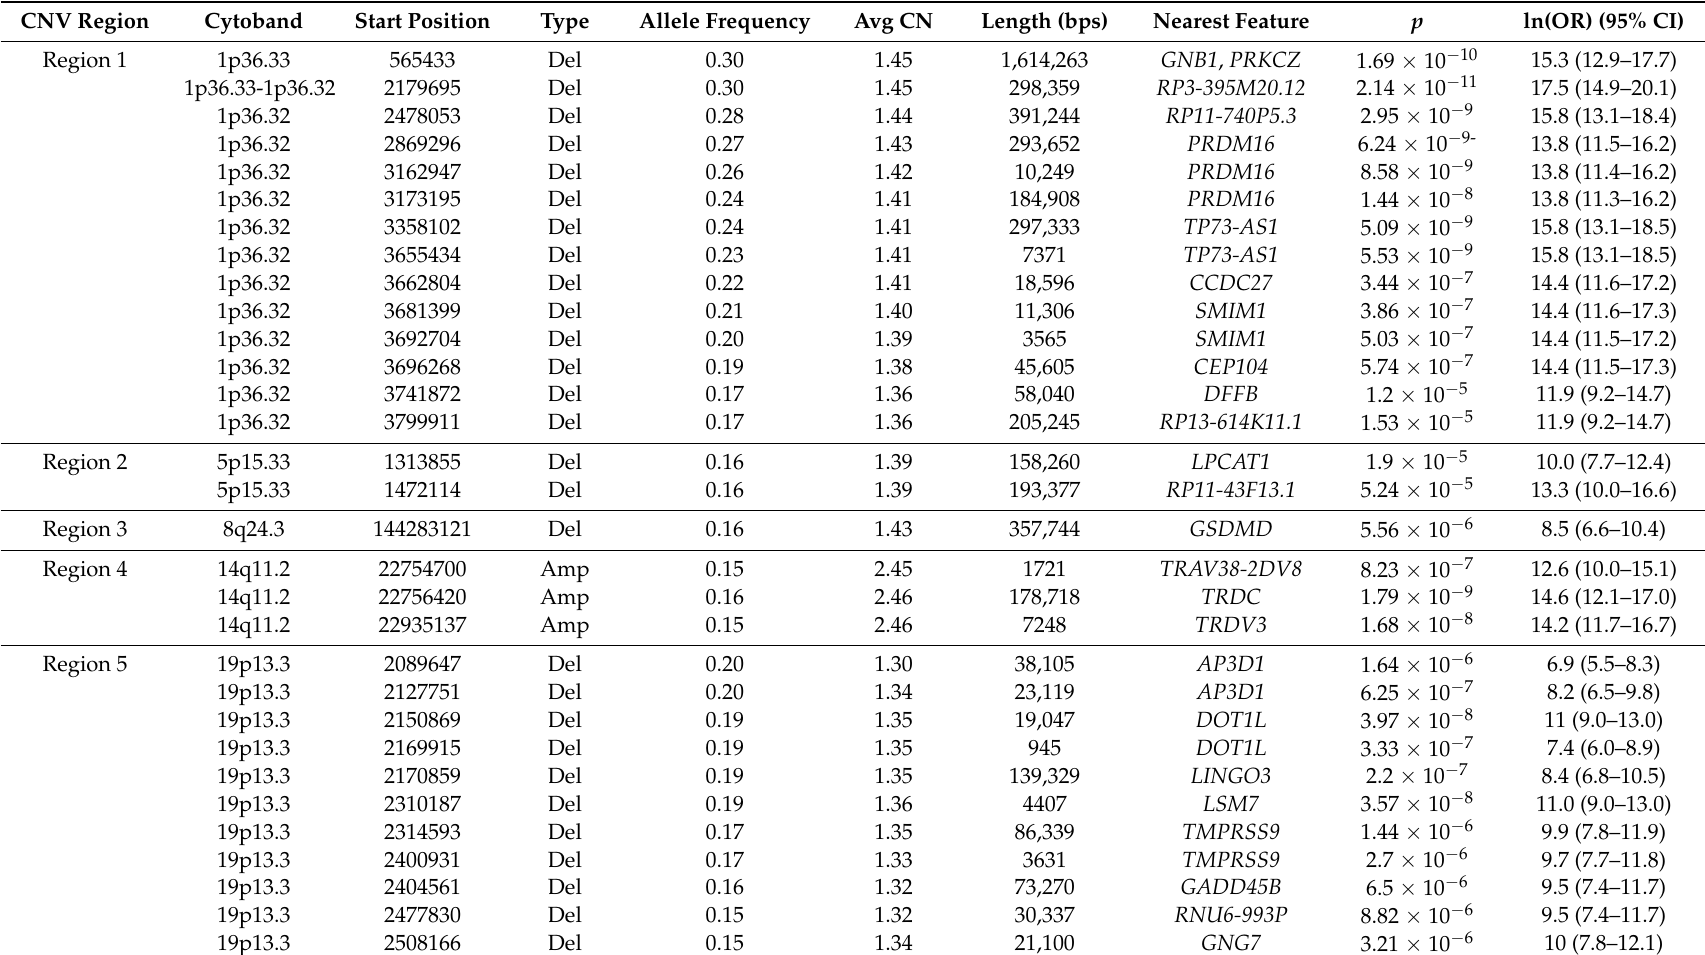
Table 2. Significant CNV regions in the 109 AF